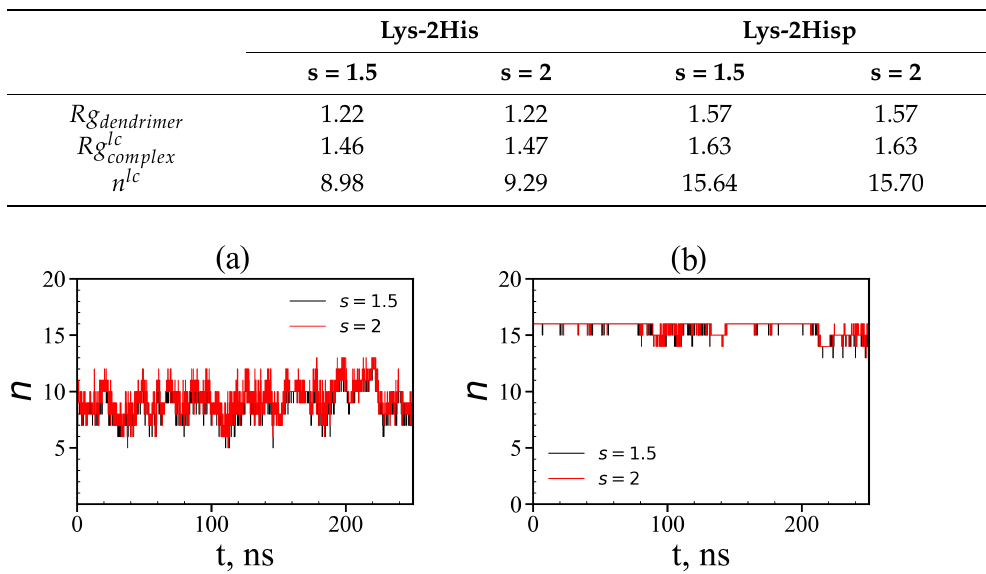
Table 6. The radius of gyration of the Lys–2His (or Lys–2Hisp) dendrimer in complex, the radius of gyration of complex Lys–2His (or Lys–2Hisp) + 16AEDG and the number of peptide molecules in